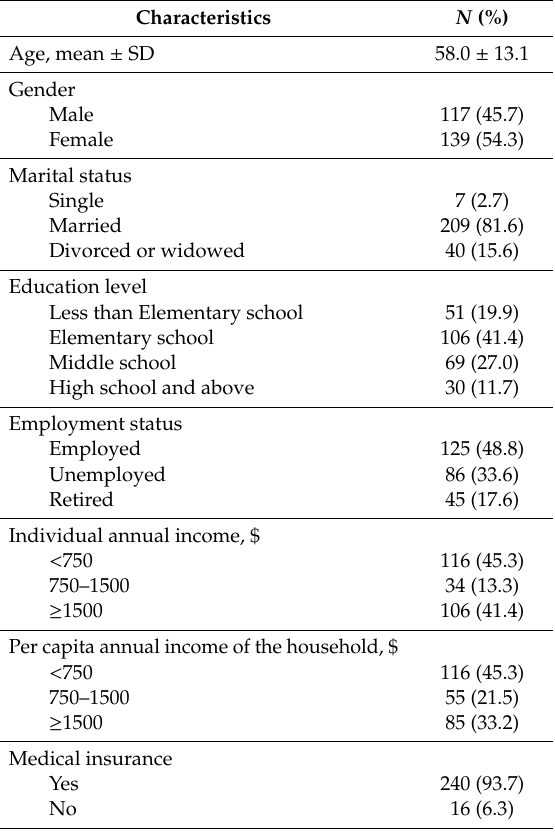
Table 1. Socio-demographic characteristics of primary caregivers ( n = 256).